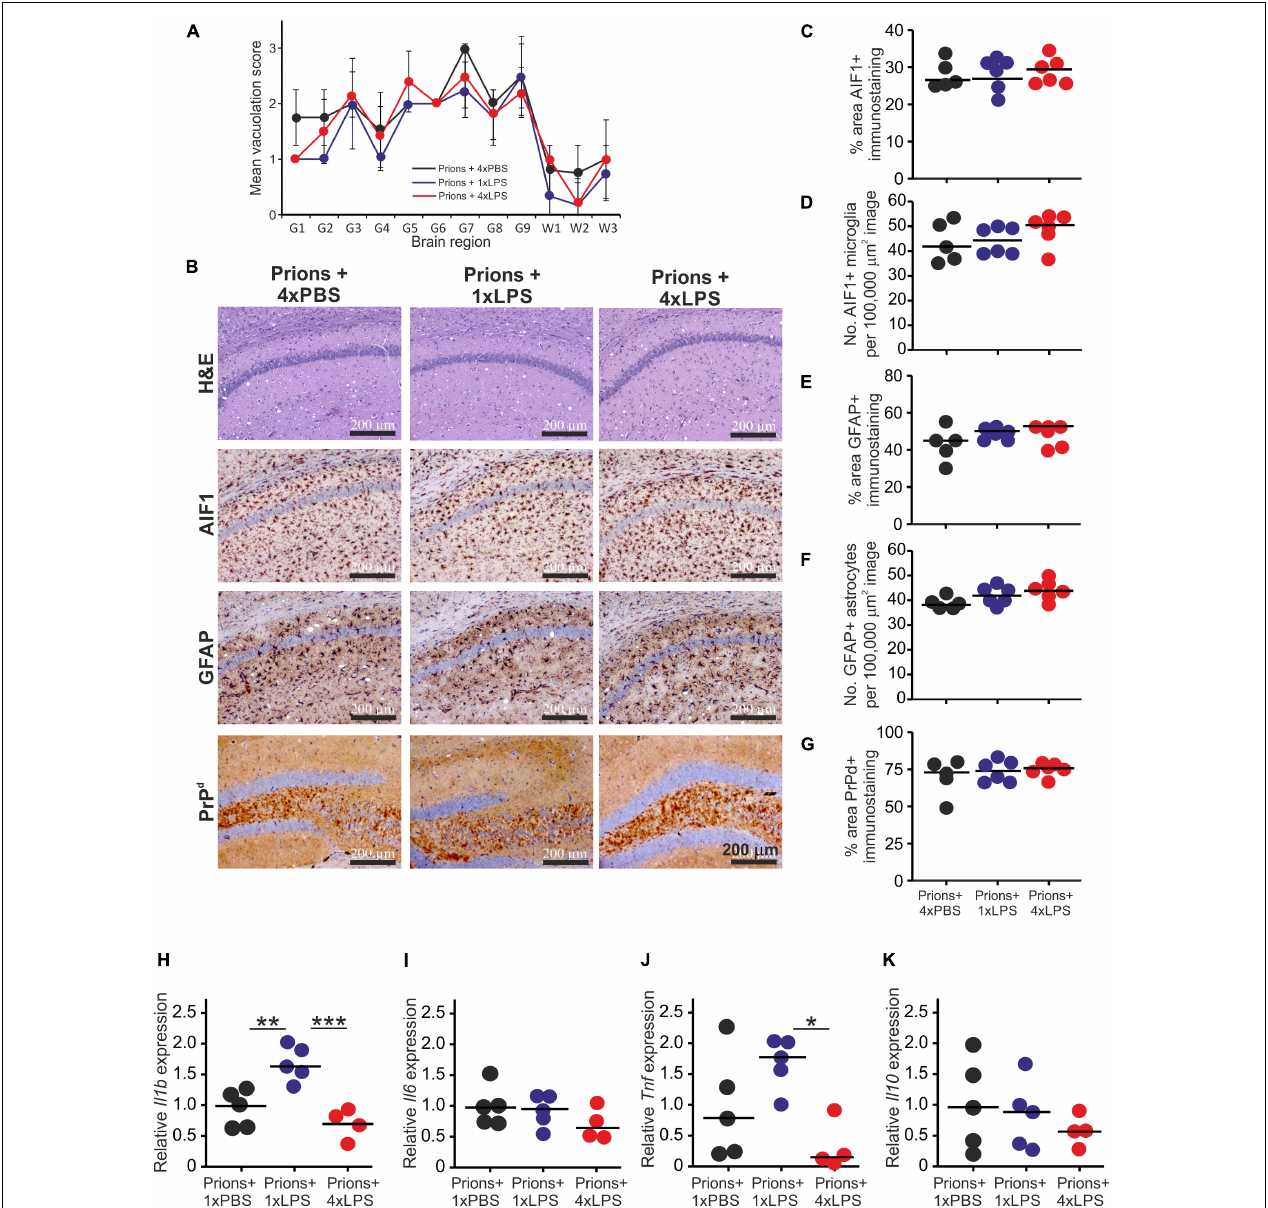
FIGURE 7 | Effect of systemic LPS treatment on the histopathological signs of prion disease in the brain. Mice were first injected with ME7 scrapie prions directly into the brain by IC injection. Thirty five days later the mice were given a either single IP LPS injection (prions + 1xLPS) or four consecutive daily IP LPS injections (prions + 4xLPS) to induce innate immune training or tolerance, respectively. A parallel group of mice were given four consecutive daily IP PBS injections (prions + 4xLPS) as a control. Brains were collected at the terminal stage. (A) The severity and distribution of the spongiform pathology (vacuolation) within each clinically affected brain from each treatment group was scored on H&E sections using a scale of 1–5 in nine gray matter regions and three white matter regions: G1, dorsal medulla; G2, cerebellar cortex; G3, superior colliculus; G4, hypothalamus; G5, thalamus; G6,hippocampus; G7, septum; G8, retrosplenial and adjacent motor cortex; G9, cingulate and adjacent motor cortex; W1, inferior and middle cerebellar peduncles; W2, decussation of superior cerebellar peduncles; and W3, cerebellar peduncles. (B) Representative images showing high levels of spongiform pathology (H&E, upper row), microgliosis (AIF1+ cells, brown, 2nd row), reactive astrocytes (GFAP+ cells, brown, 3rd row) and heavy prion disease-specific PrPd accumulation (brown, bottom row) in the hippocampus of all prion infected mice from each treatment group at the terminal clinical stage. Sections counterstained with hematoxylin to detect cell nuclei (blue). Scale bar, 200 µ m. (C,D) Comparison of the magnitude of the AIF1+ immunostaining and abundance of AIF1 + microglia, respectively, in the CA1 region of the hippocampus of mice from each group. (E,F) Comparison of the magnitude of the GFAP+ immunostaining and abundance of GFAP+ reactive astrocytes, respectively, in the CA1 region of the hippocampus of mice from each group. (G) Comparison of the magnitude of the PrP d + immunostaining in the CA1 region of the hippocampus of mice from each group. (H) Relative expression level of Il1b mRNA. (I) Relative expression level of Il6 mRNA. (J) Relative expression level of Tnf mRNA. (K) Relative expression level of Il10 mRNA. Gene expression data are normalized so that the mean level in the 1xPBS controls was 1.0. N = 4–6 mice/group; horizontal bar, median. * P < 0.05; ** P < 0.01; *** P < 0.001.